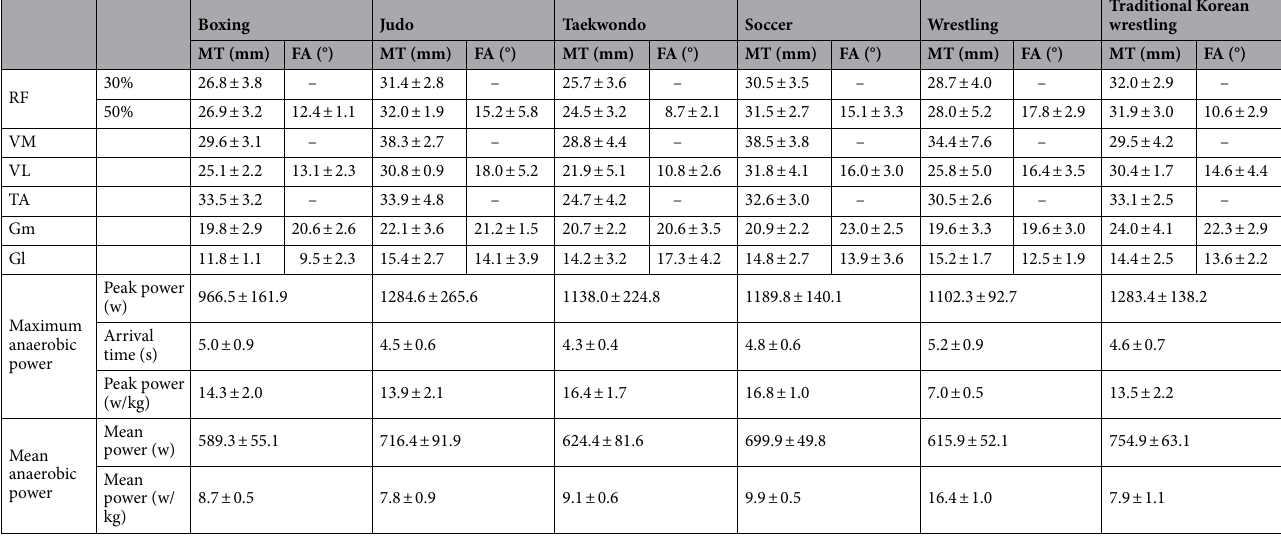
Table 2. Muscle structure and anaerobic power measurements by six sport categories. Data are presented as mean ± SD values. MT muscle thickness, FA fascicle angle, RF rectus femoris, VM vastus medialis, VL